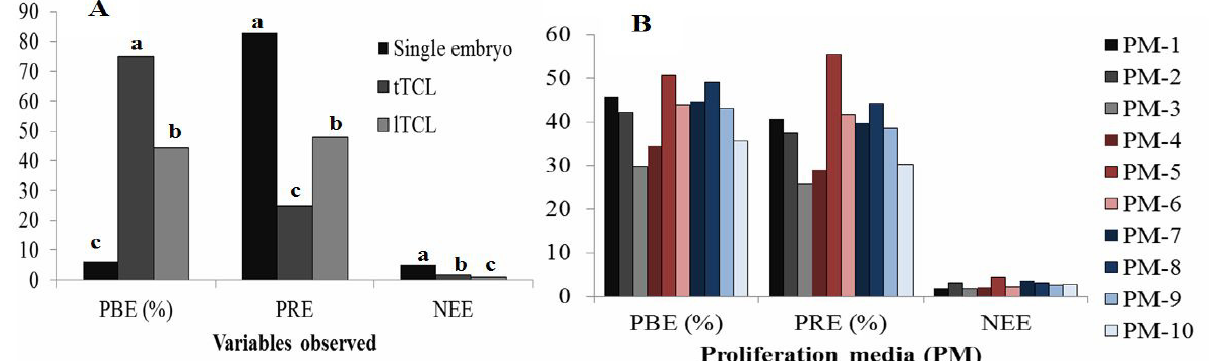
Fig. 2. Effect of explant types (A) and proliferation media (B) on embryogenesis. PM-1– half-strength MS medium supplemented with 1.5 mg/L TDZ and 0.25 mg/L BA; PM-2– half-strength MS medium augmented with 0.75 mg/L TDZ and 0.25 mg/L BA; PM-3 – half-strength MS medium containing 0.5 mg/L TDZ and 0.25 mg/L BA; PM-4– half-strength MS medium containing 0.25 mg/L TDZ and 0.25 mg/L BA; PM-5– half- strength MS medium added with 0.13 mg/L TDZ and 0.25 mg/L BA; PM-6– half-strength MS medium with full strength of vitamin containing 200 ml/L CW; PM-7– half-strength MS with full strength of vitamin augmented with 150 ml/L CW; PM-8– half-strength MS medium with full strength of vitamin containing 100 ml/L CW; PM-9– half-strength MS medium with full strength of vitamin supplemented with 50 ml/l CW; PM-10– half- strength MS medium with full strength of vitamin hormone free. Means followed by the same letter in the same column are not significant different based on HSD (p =